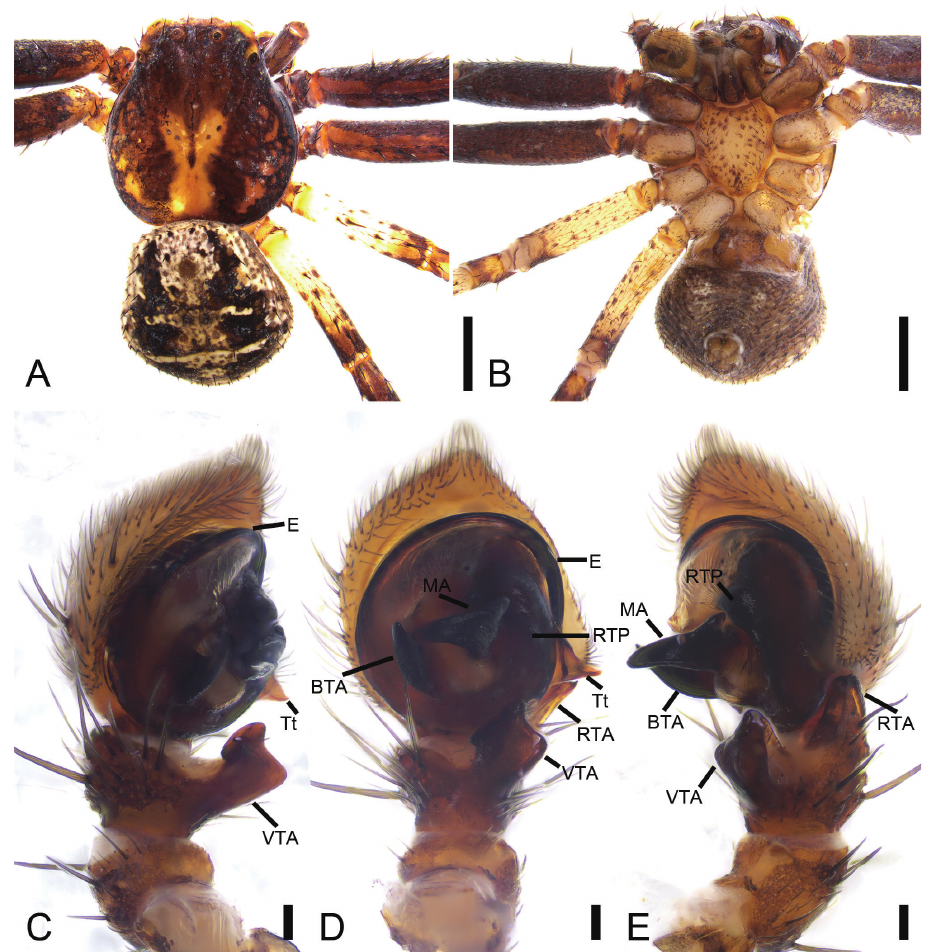
Figure 15. Xysticus lesserti Schenkel, 1963, male. A habitus, dorsal view B same, ventral view C palp, prolateral view D same, ventral view E same, retrolateral view. Abbreviations: BTA – basal tegular apo- physis, E – embolus, MA – median apophysis, RTA – retrolateral tibial apophysis, RTP – ridge-shaped tegular process, Tt – tutaculum, VTA – ventral tibial apophysis. Scale bars: 1 mm ( A, B ), 0.1 mm ( C–E